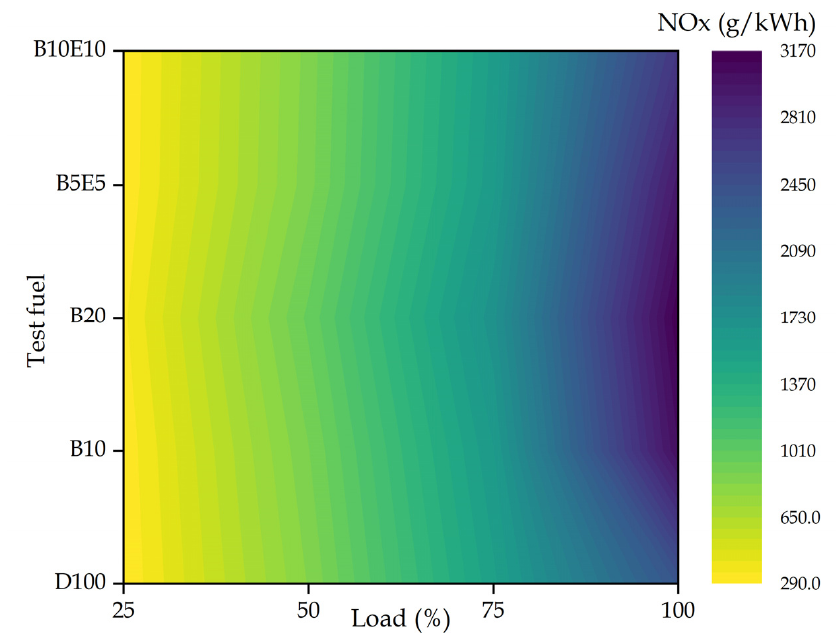
Figure 12. Variation of NOx emissions for tested fuel blends against engine load.